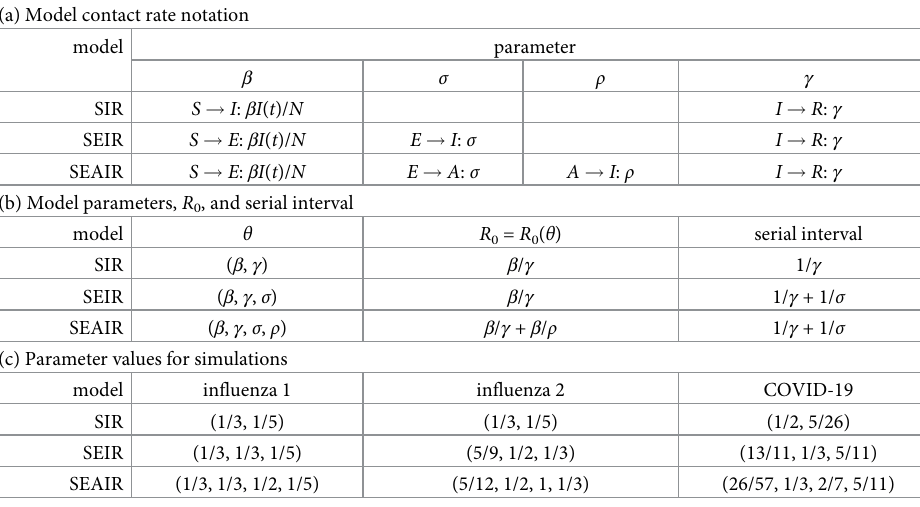
Table 1. SIR, SEIR, SEAIR model parameters and values, R 0 , serial